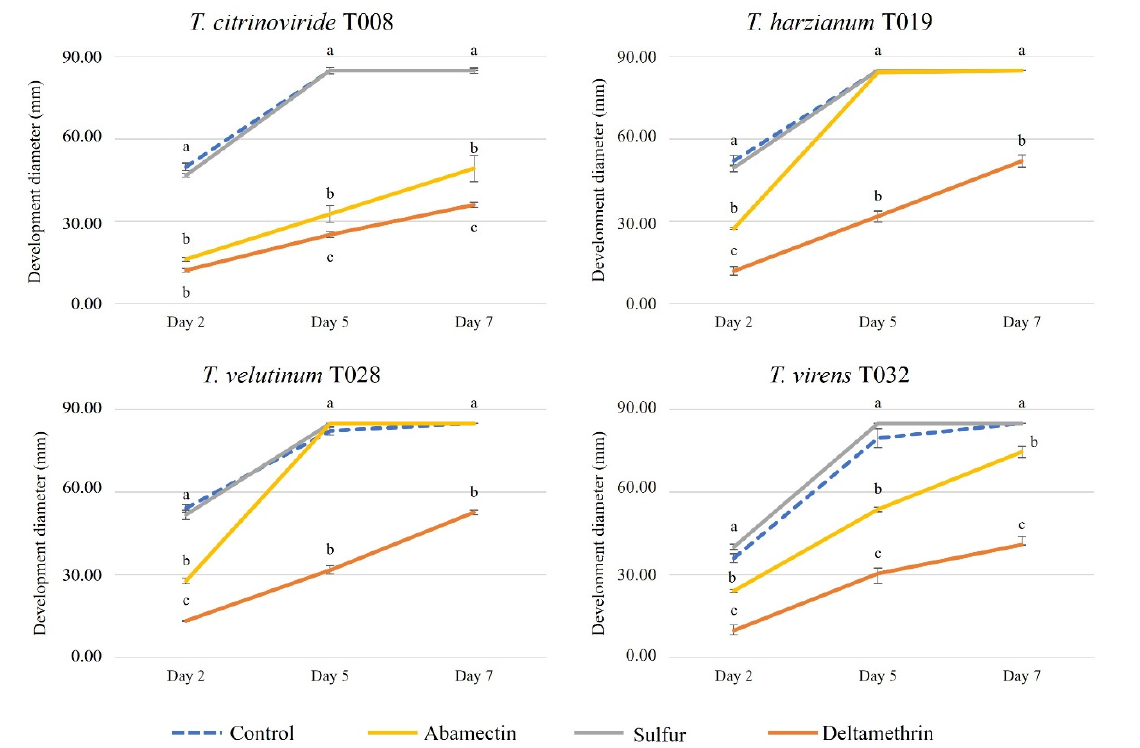
Figure 2. Development of autochthonous Trichoderma strains (diameter of growth, mm) in media with synthetic acaricides at 2, 5 and 7 days after inoculation. Blue color: control Petri dish. Yellow color: Abamectin 1.8%. Gray color: Sulfur 80%. Orange color: Deltamethrin 1.5%. The concentrations of each pesticide are specified in Table 2. Upper and lower error bars are represented and indicate standard error of the mean showing the accuracy of the calculations. Different letters indicate significant differences between synthetic acaricides (ANOVA, LSD, p < 0.05).